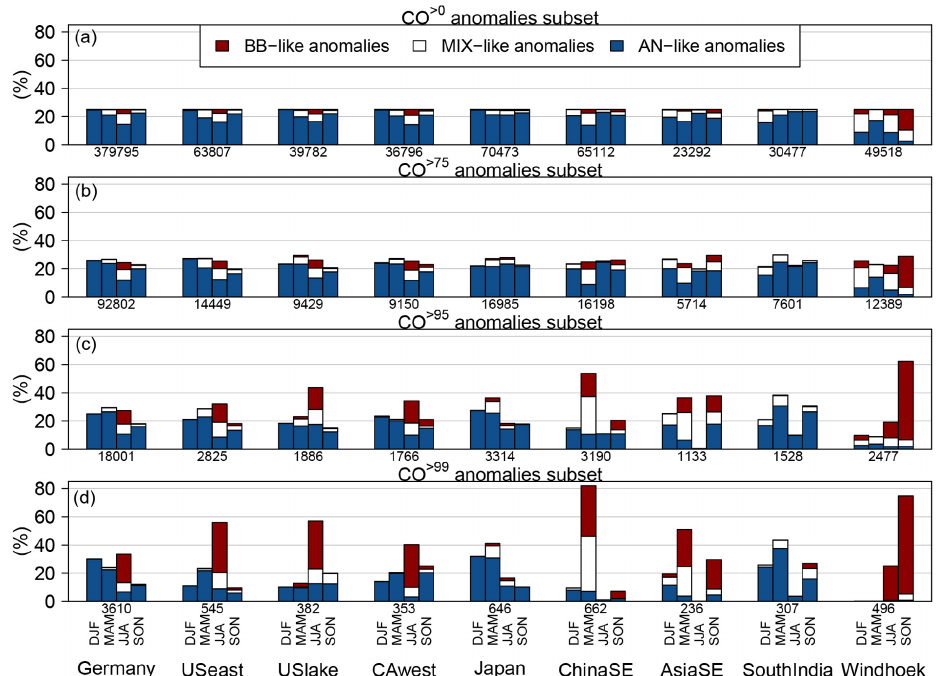
Figure 14. Seasonal distribution of the BB, MIX and AN anomalies at the different airports. Several subsets of CO anomalies are shown: CO > 0 (a) , CO > 75 (b) , CO > 95 (c) and CO > 99 (d) . The frequency of occurrence is weighted by the number of available data during each season. The number of CO anomalies is also indicated below each bar